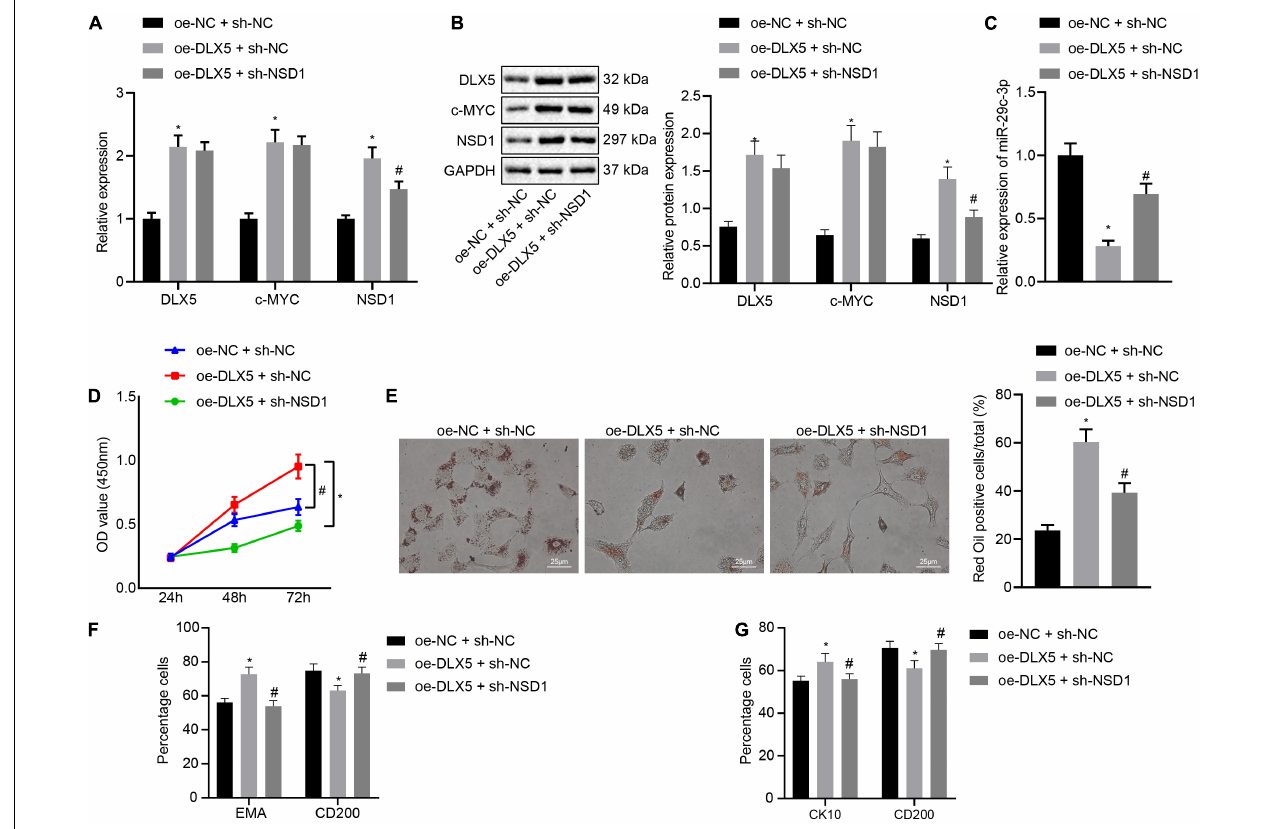
FIGURE 6 | DLX5 induces HFSC differentiation by regulating the c-MYC/miR-29c-3p/NSD1 axis. (A) DLX5, NSD1, and c-MYC mRNA expressions in HFSCs as determined by RT-qPCR. (B) DLX5, NSD1, and c-MYC protein levels in HFSCs as determined by Western blot analysis. (C) miR-29c-3p expression levels in HFSCs were measured using RT-qPCR. (D) CCK-8 assay used to detect the proliferation rates in HFSCs. (E) Oil red O staining before and after differentiation of HFSCs into sebaceous gland cells (scale bar = 25 µ m). (F) Detection of EMA and CD200 expression before and after differentiation of HFSCs into sebaceous gland cells using flow cytometry. (G) Detection of keratin CK10 and CD200 expression before and after the differentiation of HFSCs into epidermal cells using flow cytometry. * p < 0.05 compared with treatment of oe-NC + sh-NC; # p < 0.05 compared with treatment of oe-DLX5 + sh-NC. The data were expressed as mean ± standard deviation. Comparisons among multiple groups were performed using one-way ANOVA and Tukey’s test. Comparisons among multiple groups at different time points were performed using two-way ANOVA and Bonferroni test. The experiment was repeated three times.